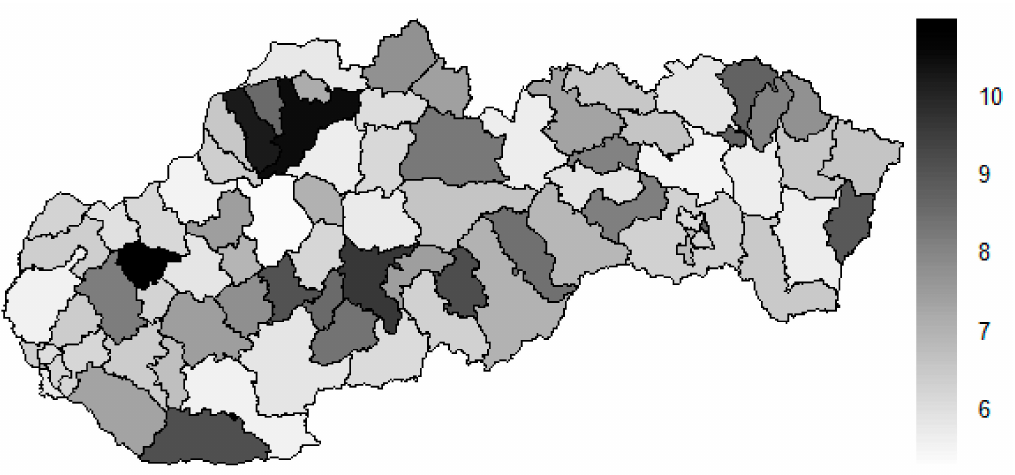
Figure 19. Preventable mortality similarity map of the districts for the female sex in the year 2008. Source: own elaboration by the authors.